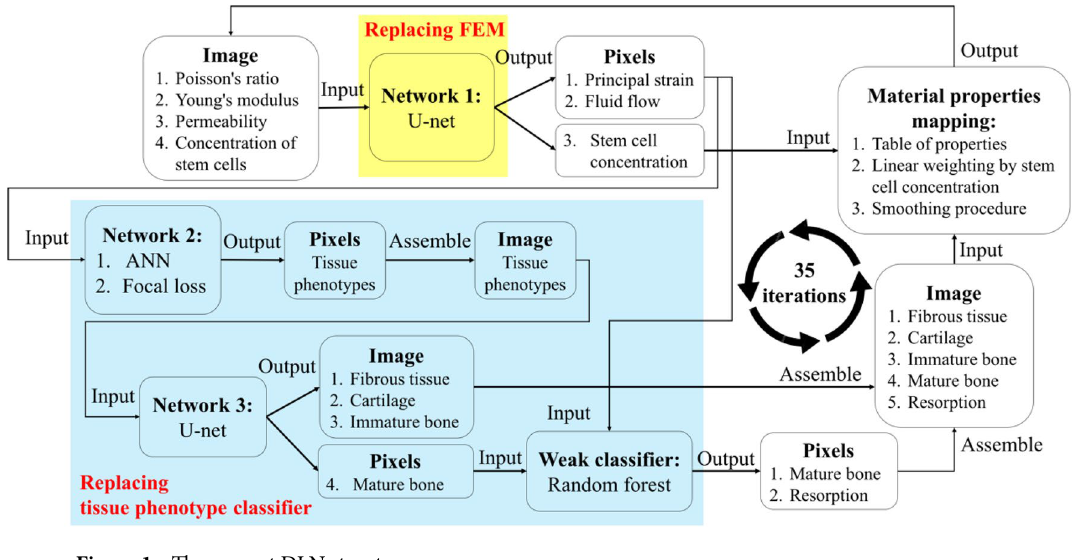
Figure 1. The current DLN